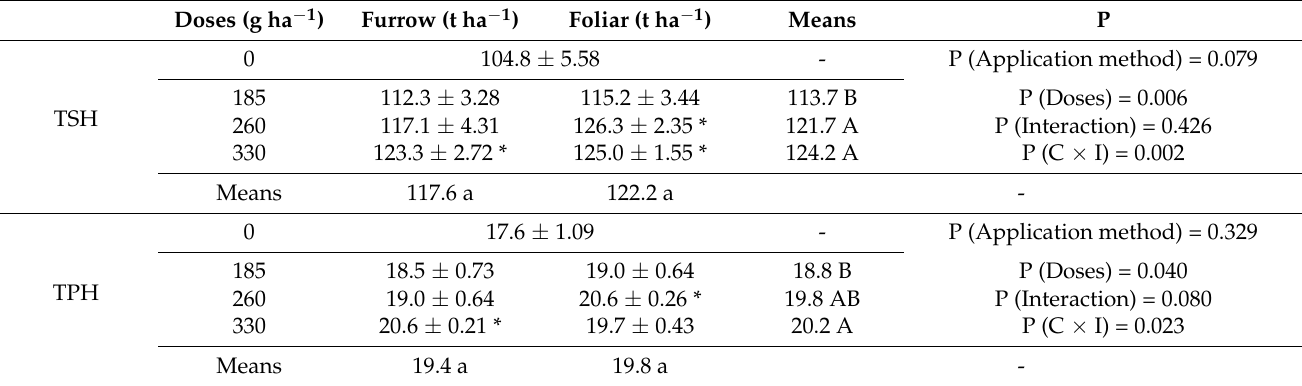
Table 6. Average values for tons of stalks per hectare (TSH) and tons of pol per hectare (TPH) as a function of the doses and application methods of Zn (df =